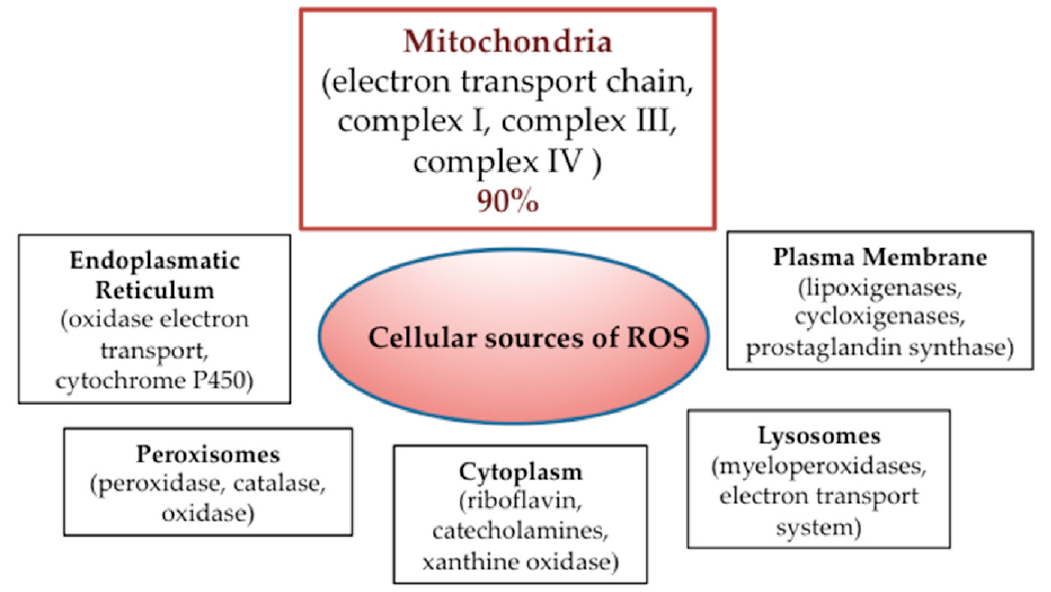
Figure 1. The main intracellular sources of ROS.